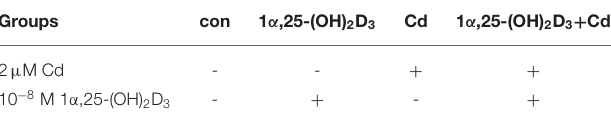
TABLE 1 | The grouping of Cd and 1 α ,25-(OH) 2 D 3 combined treatment. Groups con